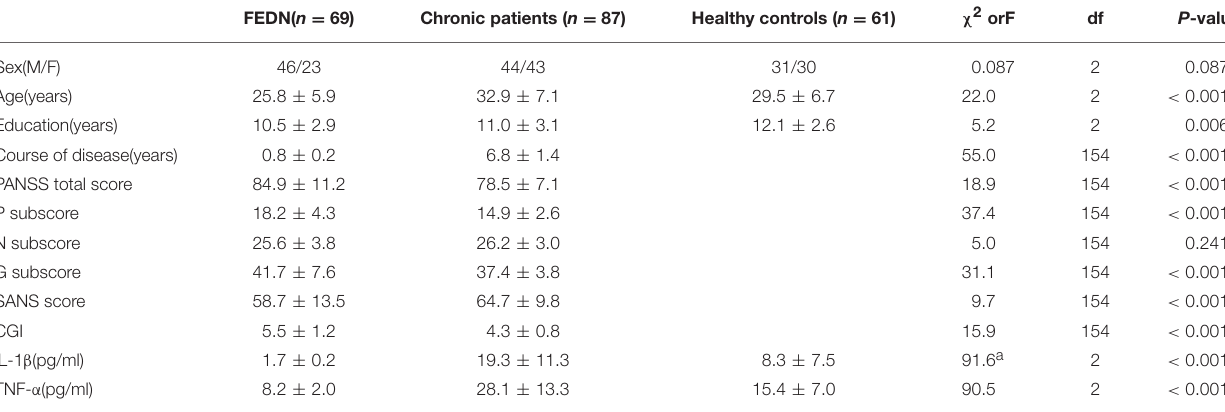
TABLE 1 | Demographics of FEDN, chronic patients with schizophrenia and healthy